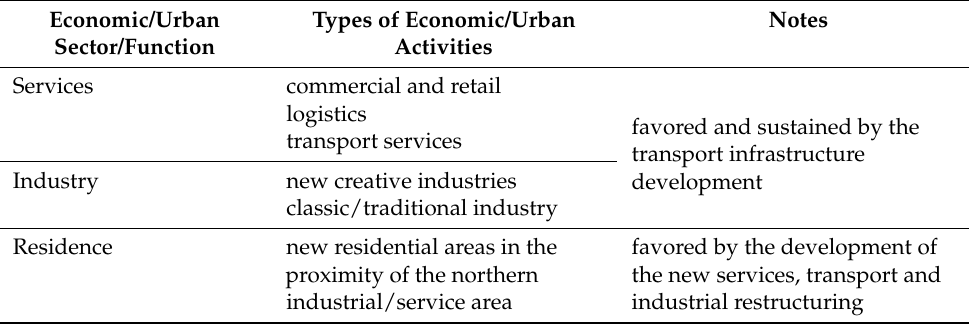
Table 1. Future perspectives in the local development/evolution of the northern industrial area of the municipality of